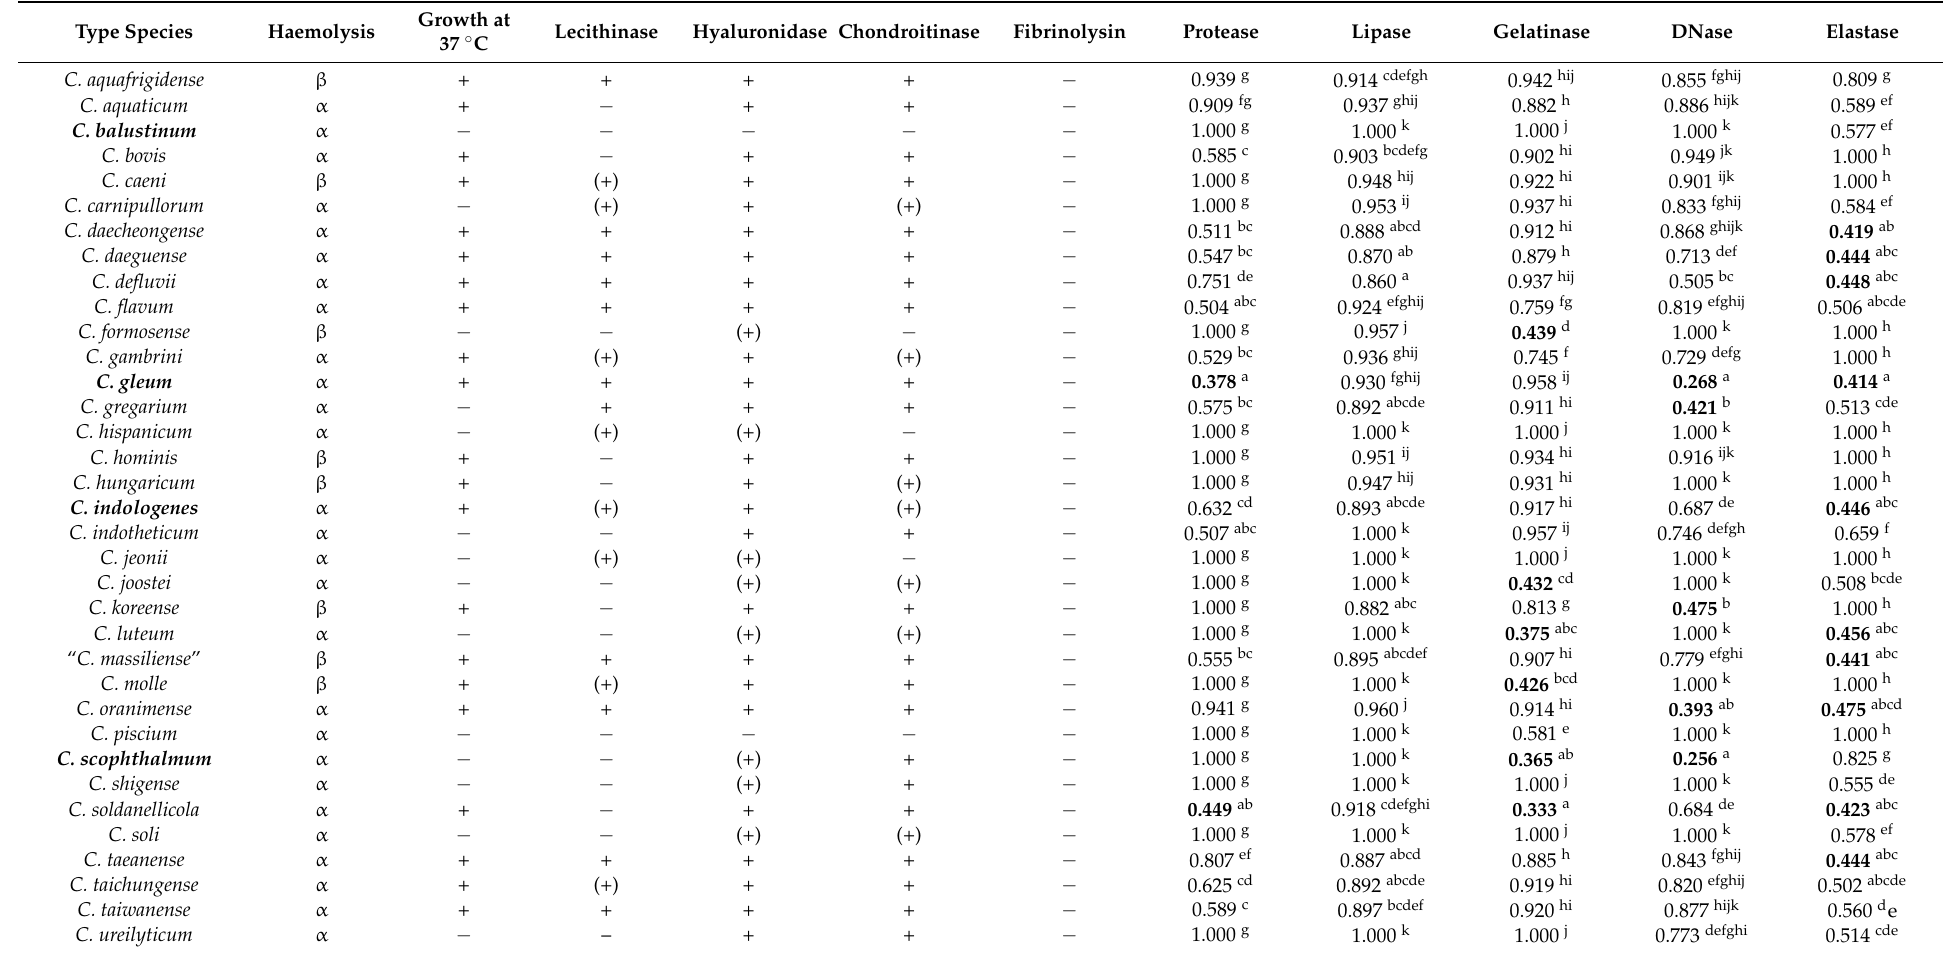
Table 2. Qualitative (absence/presence) analysis of haemolysis, growth at 37 ◦ C, production of lecithinase, hyaluronidase, chondroitinase and fibrinolysin, and quan- titative analysis (Z-score values) production of protease, lipase, gelatinase, DNase and elastase of the 37 Chryseobacterium species and Elizabethkingia meningoseptica evaluated in this study. α , alpha haemolysis; β , beta haemolysis; +, present/positive; − , absent/negative; (+), weakly positive; N/A. not applicable. Species in bold are the control strains, isolated from human clinical samples or diseased fish. Highest enzyme production (Z-score < 0.5) is indicated in bold. n =